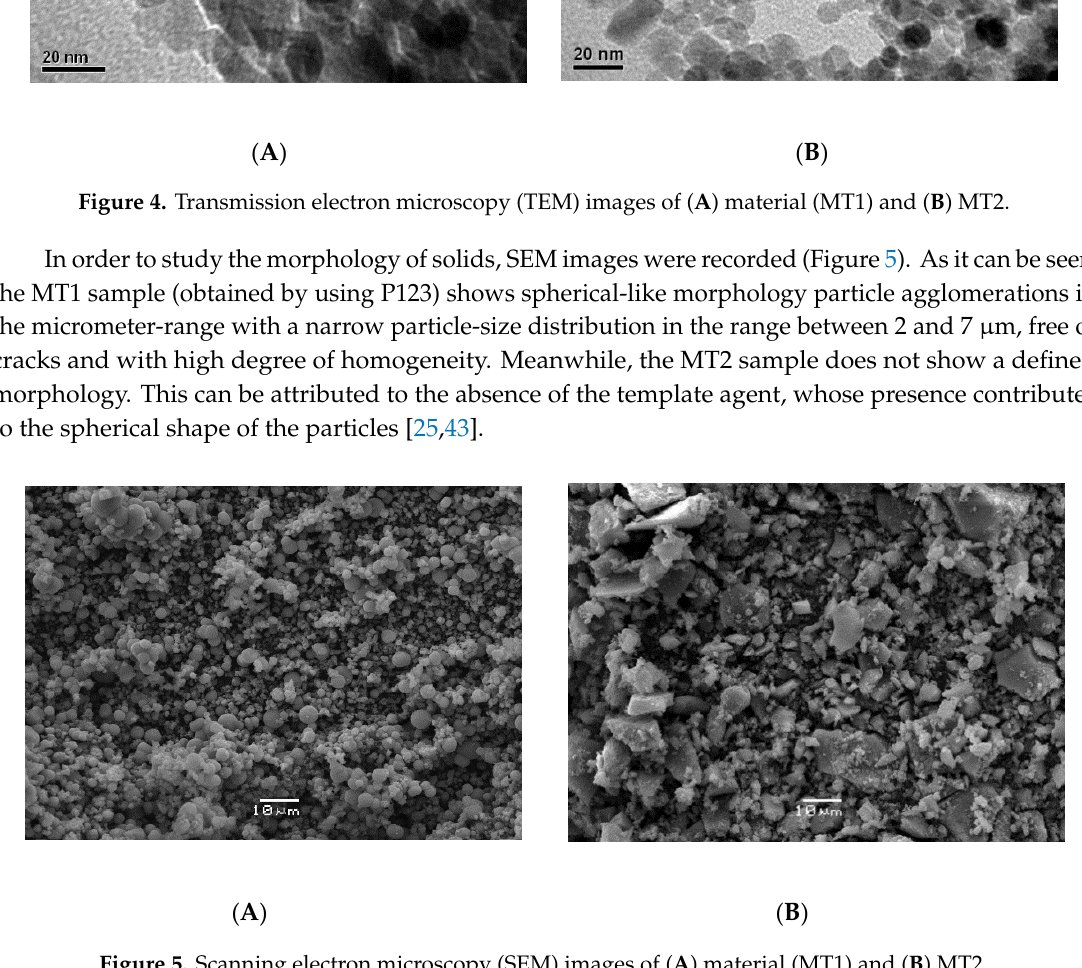
Figure 5. Scanning electron microscopy (SEM) images of ( A ) material (MT1) and ( B ) MT2.